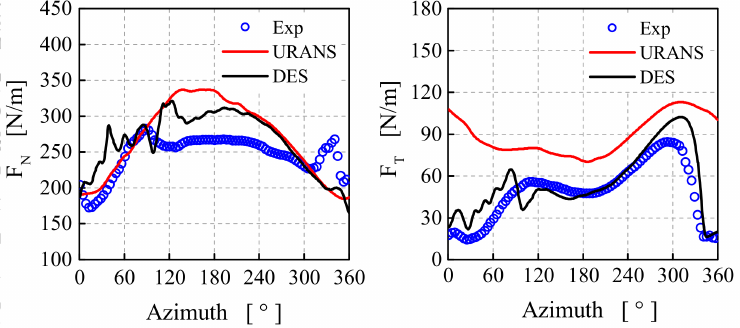
Figure 14. Normal and tangential forces variations at 25% span at 24 m/s wind inflow.